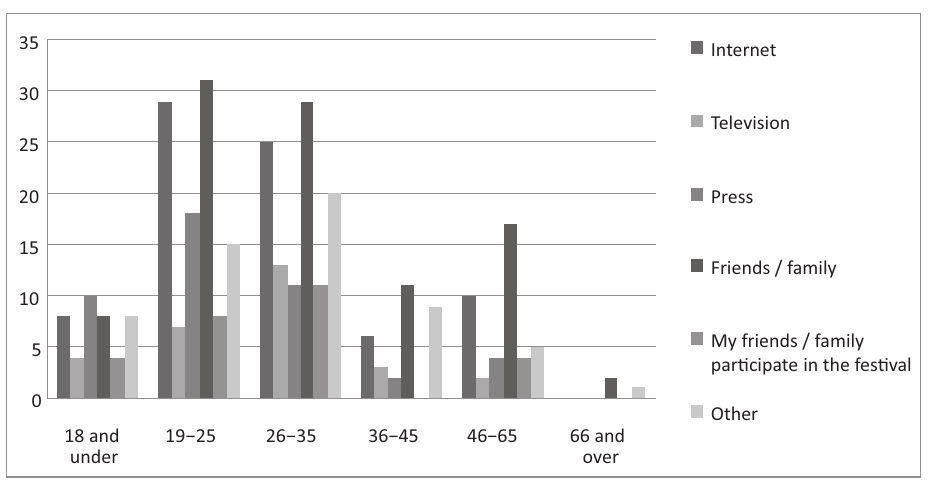
Fig. 17. Correlation between a channel visitors have found information about the festival and gender